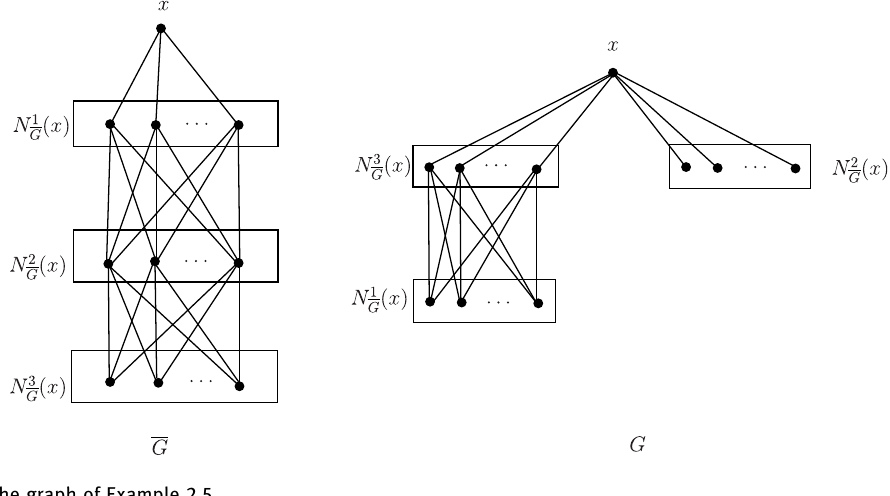
Figure 3: The graph of Example